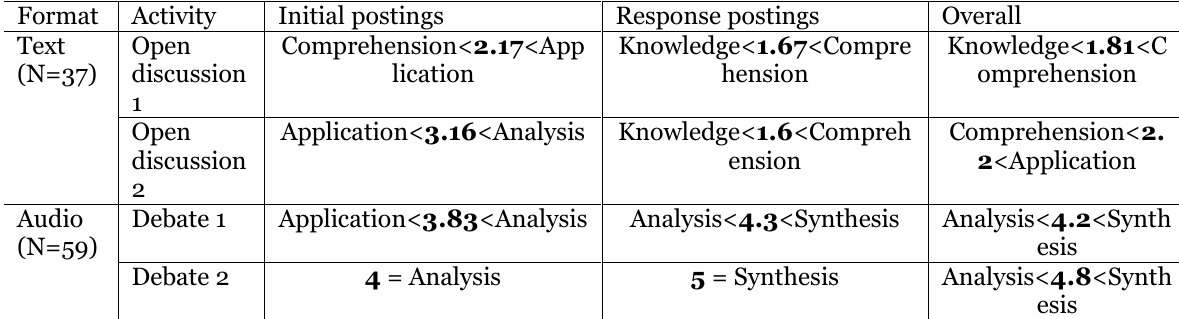
Average Levels of Thinking in Discussion Postings (Message